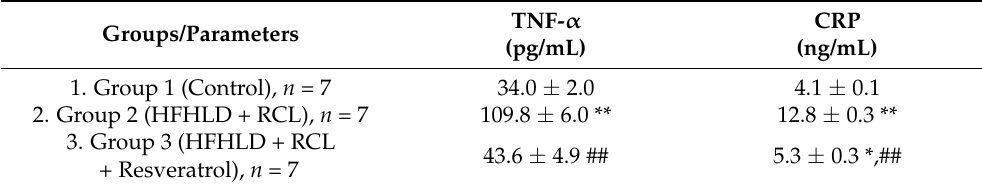
Table 2. Effects of resveratrol on the systemic inflammatory response indices in the serum of rats fed a high-fructose high-lipid diet (HFHLD) under round-the-clock lighting (RCL). TNF ‐α CRP Groups/Parameters (pg/mL) (ng/mL)